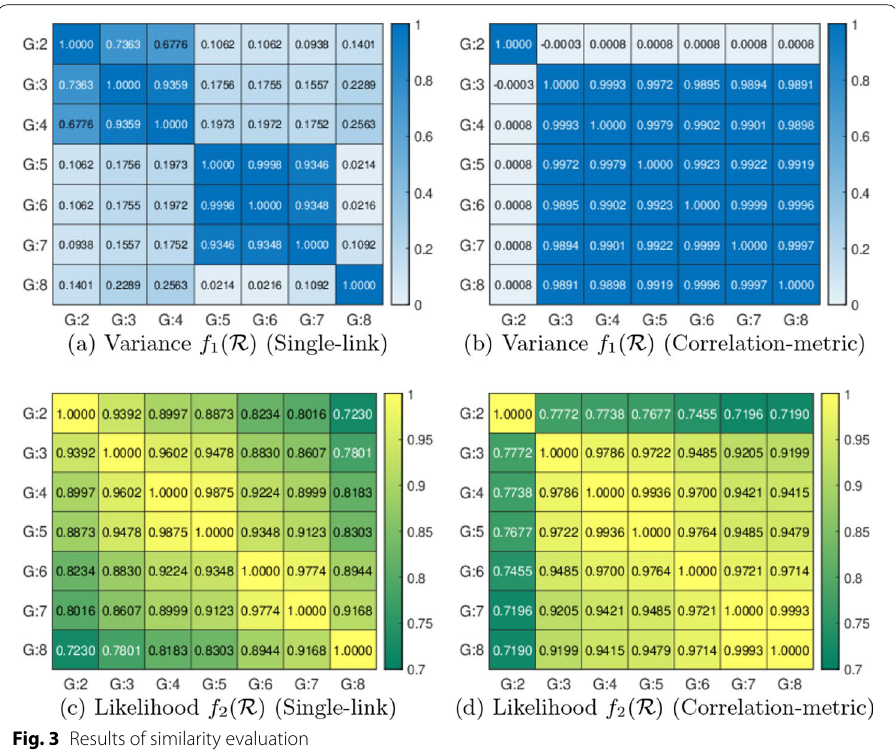
Fig. 3 Results of similarity